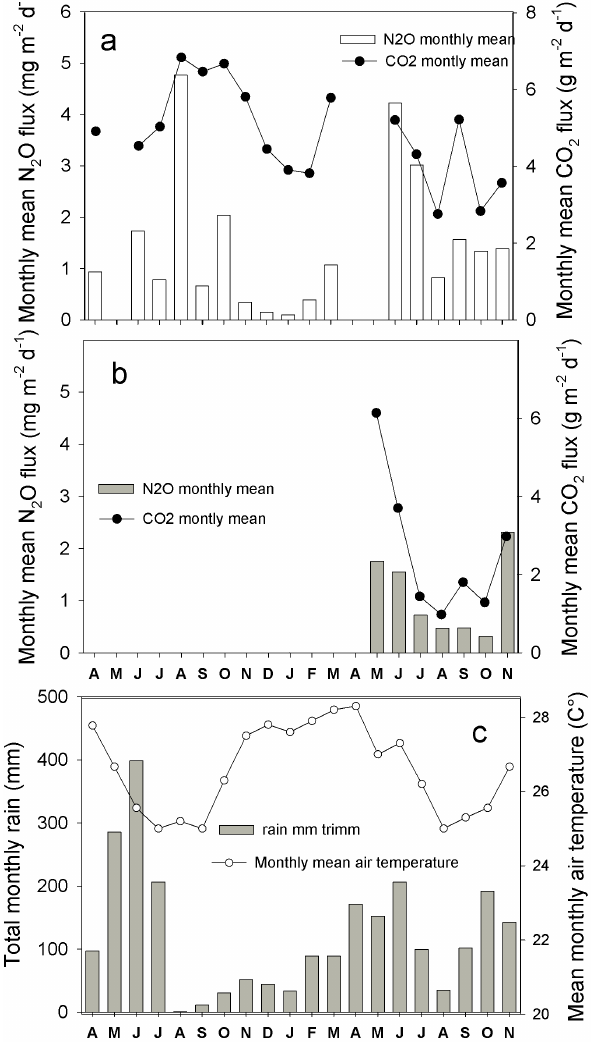
Fig. 3. Monthly mean N 2 O flux (bars) and soil CO 2 flux (black dots) calculated for the uphill (a) and downhill (b) areas; mean air temperature and total monthly rainfall (c) .